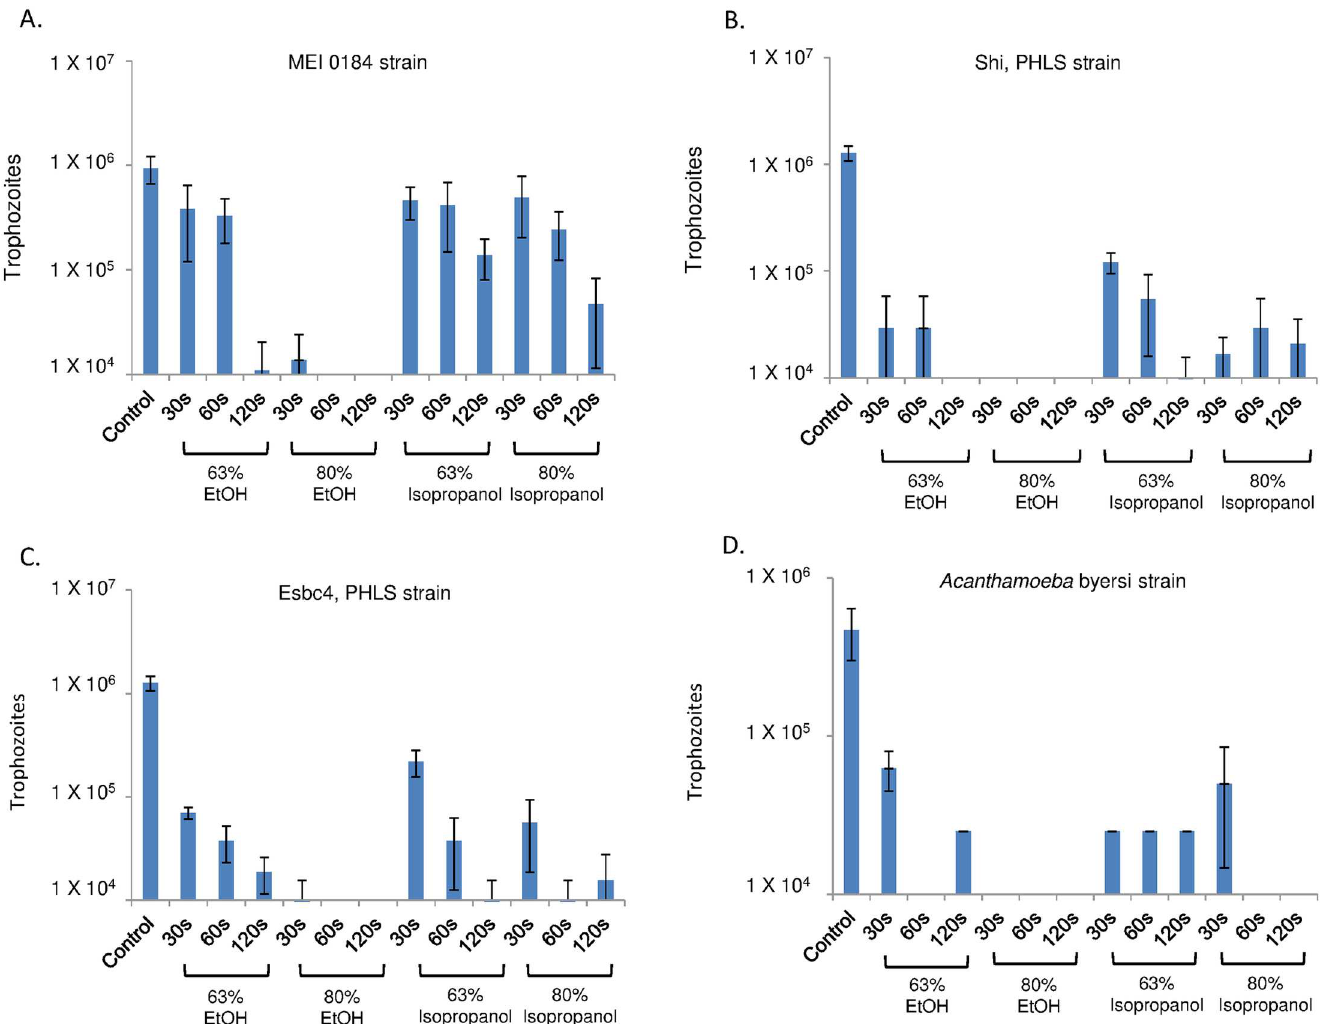
Fig 3. Treatment of Acanthamoeba cysts with alcohols reduces excystationand trophozoite growth. Log plots of excystation and growth of A . castellanii MEI 0184 strain (A), Acanthamoeba spp . Shi (B) and Esbc4 (C) strains, and A . byersi (D). Comparedto killingof trophozoites (Fig 2), killingof cysts was much slower with 63% ethanoland much less effective with isopropanol. However, all four sets of Acanthamoeba cysts were rapidly killed by 80% ethanol.